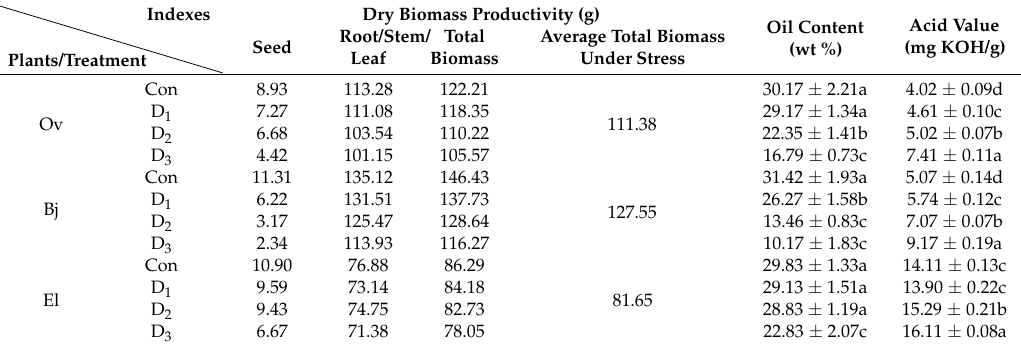
Table 1. Effect of different levels (Con: 25% moisture, D 1 : 17% moisture, D 2 : 14% moisture, and D 3 : 11% moisture) of drought stress on the biomass production of three plant species. Different letters indicate a significant difference between treatments of the same plant ( p < 0.05) and different lowercase letters in the same row denote significant differences among four drought treatments ( p <